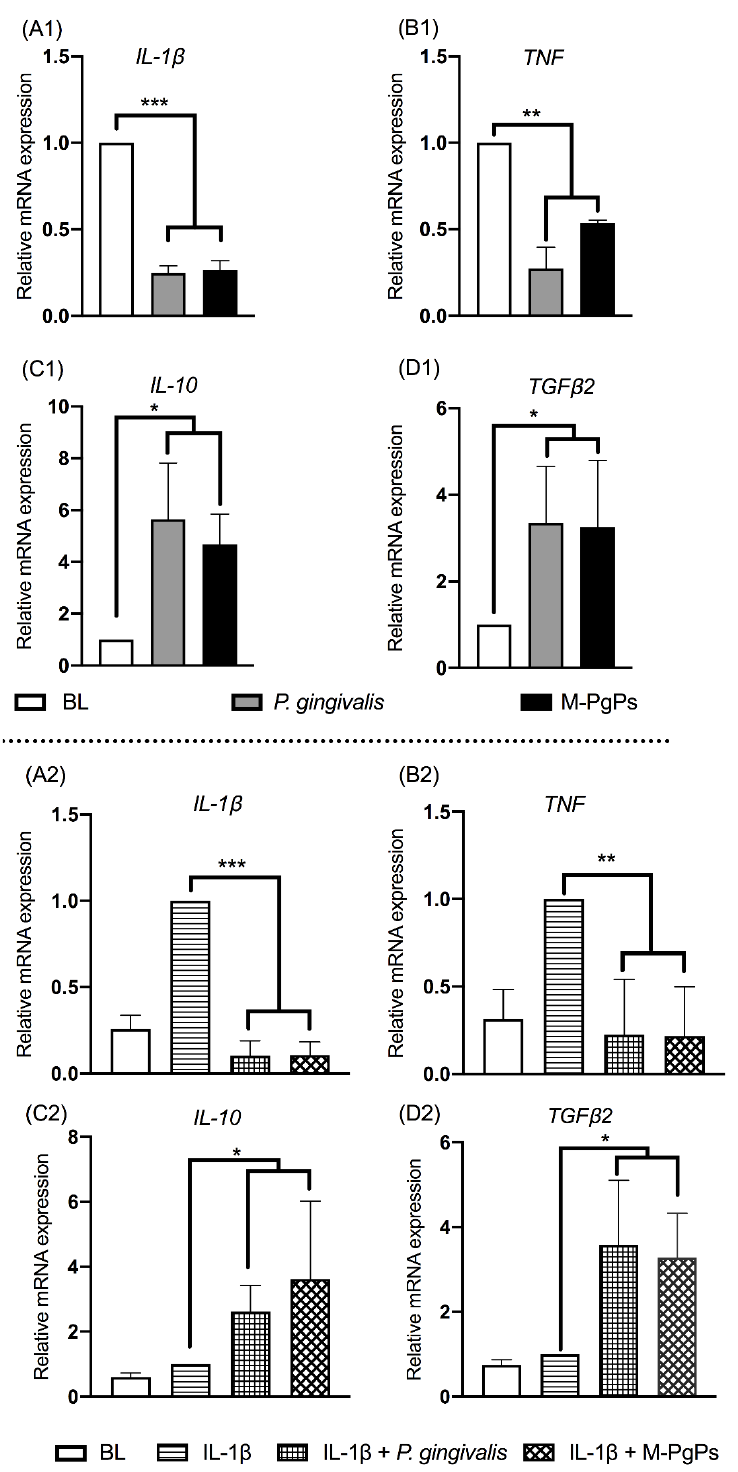
Figure 1. M-PgPs inhibit the innate host defense of HGECs. Relative mRNA expression levels of IL-1 β ( A1 , A2 ), TNF ( B1 , B2 ), IL-10 ( C1 , C2 ), and TGF- β 2 ( D1 , D2 )in HGECs after the treatment of M-PgPs (1:100) for 24 h were analyzed using RT-qPCR. ( A1 – D1 ) Under normal condition without IL-1 β pre-treatment. ( A2 – D2 ) Under inflammatory condition with IL-1 β pre-treatment. HGECs without any treatment served as blank control (BL). HGECs treated with P. gingivalis (1:100, 24 h) served as positive control. IL-1 β (1 ng mL − 1 ) was added 6 h before M-PgPs and P. gingivalis treatment. * p < 0.05; ** p < 0.01; *** p < 0.001. Data represent the mean ± SD of three independent